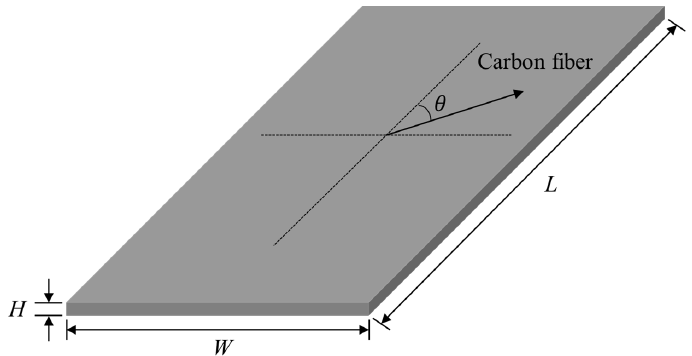
Figure 1. Configuration of the simple rectangular carbon-fiber-reinforced plastic (CFRP) specimen: